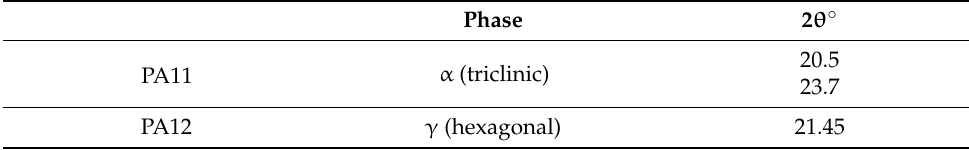
Table 3. XRD experimental peak positions in PA11 and